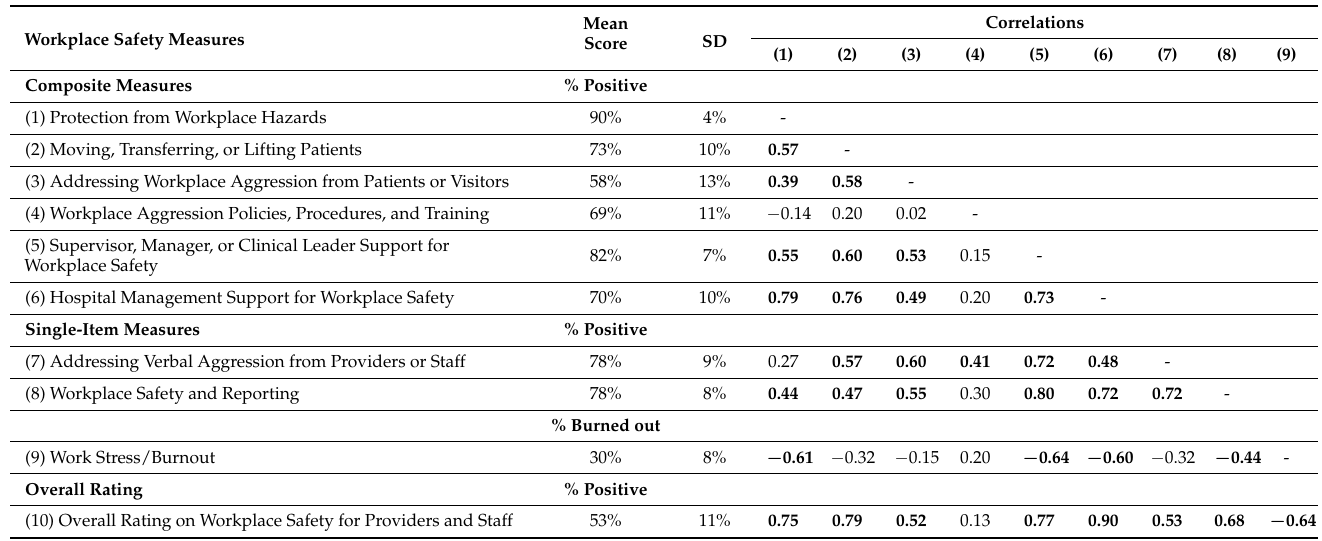
Table 9. Hospital-level percent positive scores and correlations for the final SOPS Workplace Safety measures ( N =